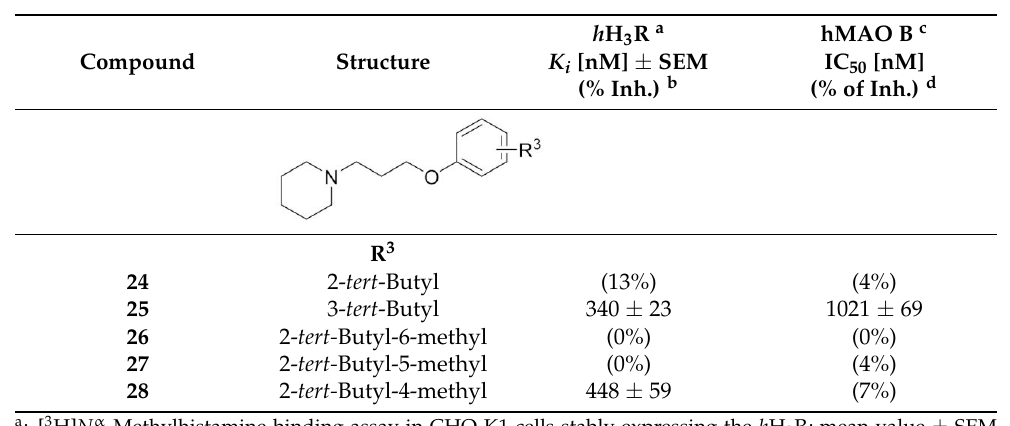
Table 3. In vitro affinities for human histamine H 3 receptor and human MAO B inhibitory activities of the target compounds 24 – 28 .